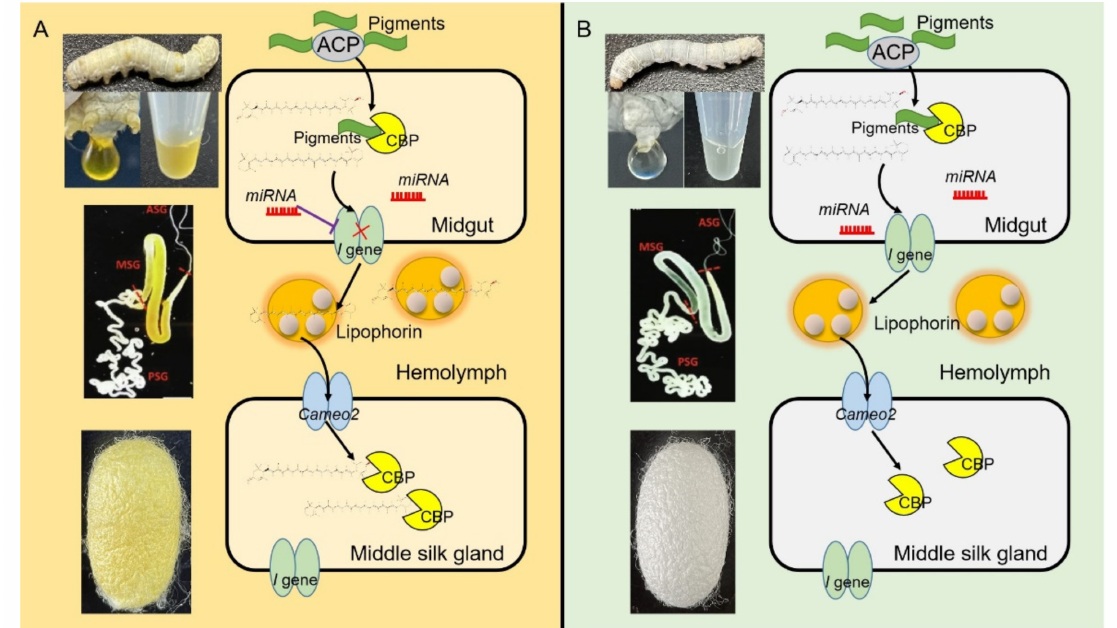
Figure 9. The miRNAs regulate the yellow blood inhibitor gene ( I gene) and participate in the absorption of pigment molecules in the yellow and white cocoon silkworm NB and 306. Among them, ACP represents absorbent of carotenoid pigment, CBP represents a carotenoid-binding protein, I gene represents the yellow blood inhibitor genes KWMTBOMO10339 and KWMTBOMO16553 that were identified in this work, and miRNA represents the five miRNAs that were analyzed in this work. ( A ): The mechanism of miRNA and I gene regulation to form a yellow cocoon in NB silkworm; ( B ): The mechanism of miRNA and I gene regulation to form a white cocoon in 306